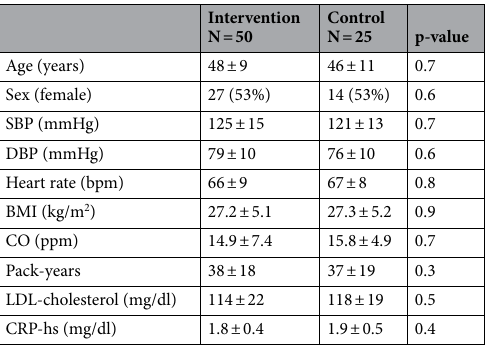
Table 1. Characteristics of the study cohort. SBP systolic blood pressure, DBP diastolic blood pressure, BMI body mass index, BP blood pressure, CO exhaled carbon monoxide, CRP-hs C-reactive protein highly sensitive, values are mean ±